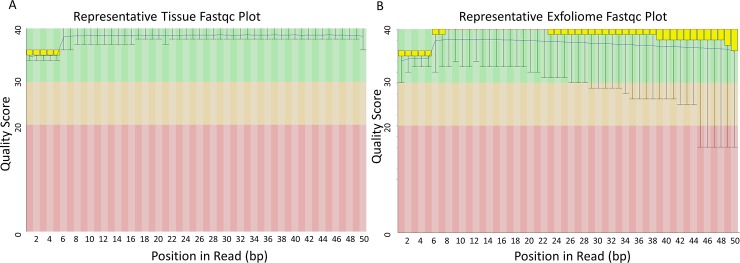
Sequencing quality of equine exfoliome and mucosal tissue are of excellent quality.FastQC box plots of quality scores per read position of RNA-Seq data. Y-axis: Phred quality scores 0–40 colored based upon quality of the scores (green = excellent quality (30–40), yellow = acceptable quality (20–30) and red = poor quality 0–20). The yellow area in the box represents the inter-quartile range from the 25th to the 75th percentile. The error bars include the 10th and the 90th percentiles. The red lines inside the box plot are the median value of phred scores for the nucleotide range, and the blue curve represents the mean value. A) Representative fastqc plot from tissue showing quality score per base of fastq sequences. B) Representative fastqc plot from equine exfoliome showing quality score per base of fastq sequences.